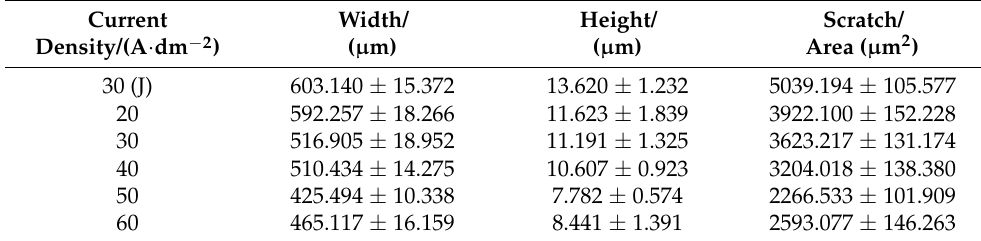
Table 5. Coating wear mark